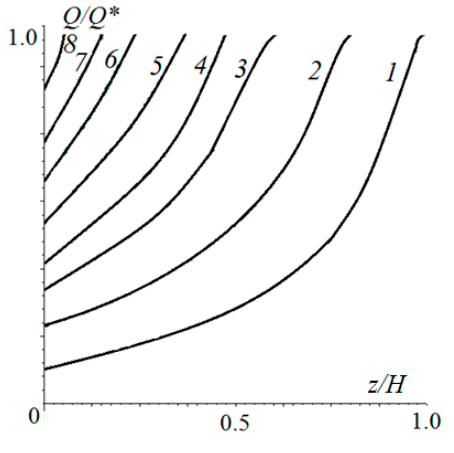
Figure 6. Distribution of the damage function within the layer at different phases of fatigue: µ = 0,